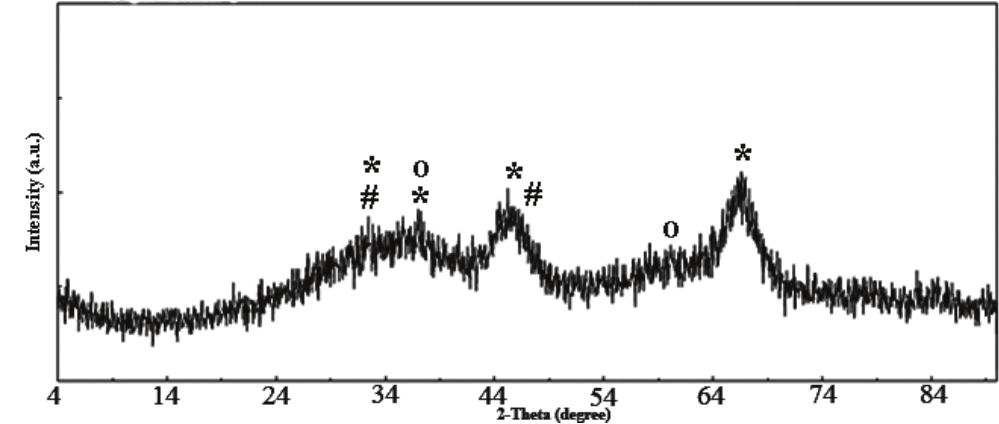
Fig. 1. . XRD pattern of C1 catalyst calcined at 650ºC; (*) γ-Al